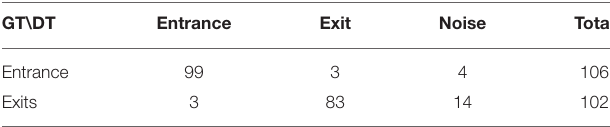
TABLE 1 | Summary of the best mAP when training on skeletons composed of 1, 2, 3, and 5 parts and YOLO-v3 on Thorax.